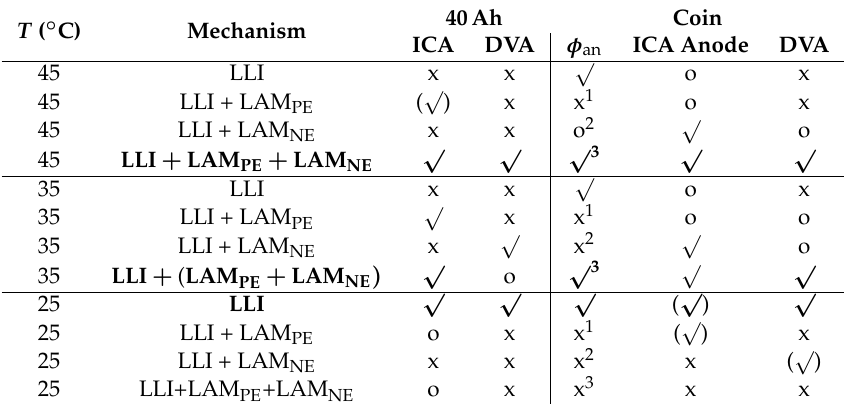
Table 7. Indications resulting from the aging analyses to detect the main aging mechanisms of the cells. √ The " " symbol represents a strong indication for a specific aging type (LLI, LAM PE , ...). A "( that several but not all factors agree for a specific aging mechanism. If the cell results did not conform to the mechanism, a “x” symbol is used in the table. A “o” symbol means an ambiguous relationship. T ( ◦ C)